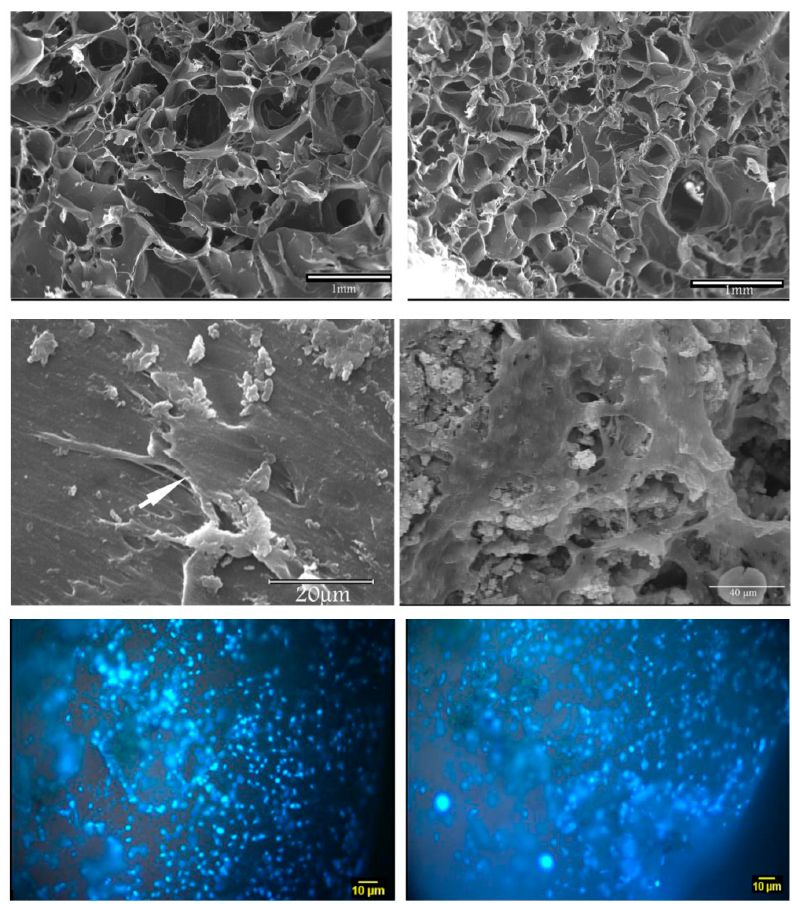
Figure 3. SEM micrographs of ( left ) gelatin/collagen scaffolds and ( right ) gelatin/collagen/BG scaffolds for cardiac tissue repair. Top: Pictures of bare scaffolds; middle: Cells seeded on the scaffolds; bottom: Nuclei staining of cells grown on scaffolds 15 days post cell seeding. Images from Barabadi et al. [74] © Elsevier.